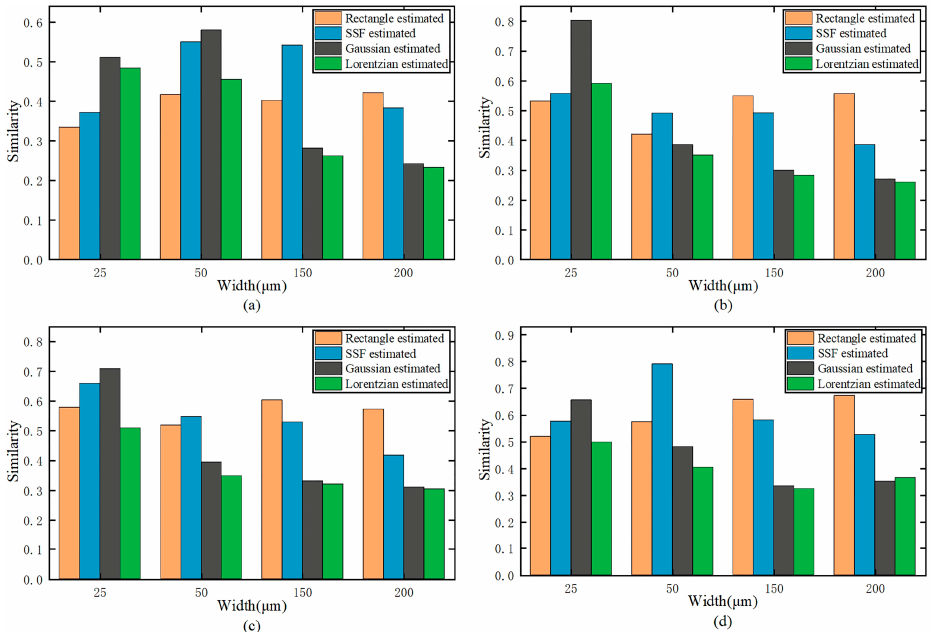
Figure 5. Similarity between simulated waveform and measured waveform with different slit functions for wavelengths of ( a ) 365. 010 nm, ( b ) 696.543 nm, ( c ) 763.511 nm, and ( d ) 912.297 nm.